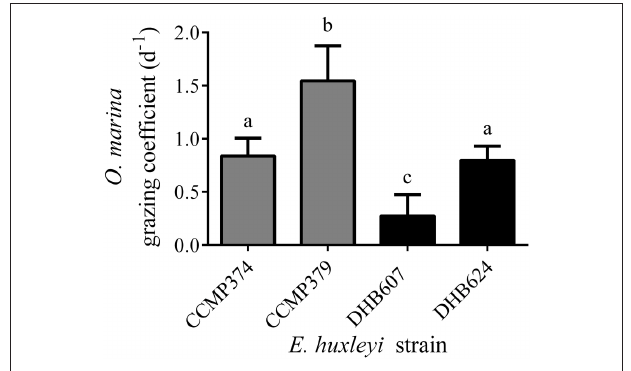
FIGURE 1 | Grazing of Oxyrrhis marina LB1974 on four Emiliania huxleyi strains over 48h. Grazing is expressed as mean grazing coefficient (d − 1 ), averaged over multiple concentrations of E. huxleyi . Error bars represent ± 1 S.D. E. huxleyi strains include non-calcified strains CCMP374 and CCMP379 (denoted by gray bars) as well as calcified strains DHB607 and DHB624 (black bars). Letters (a–c) indicate statistical equivalency from ANOVA with Tukey post-test ( n = 10